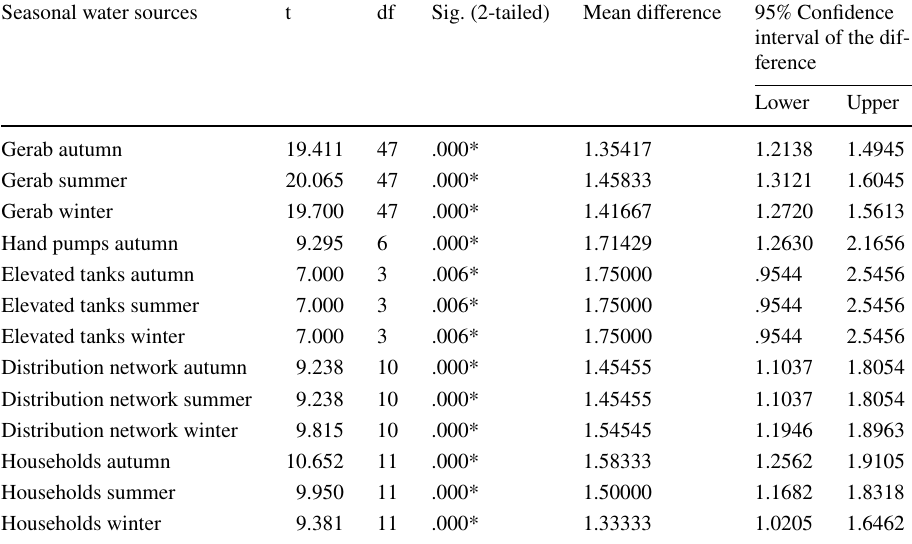
Table 5 One-Sample